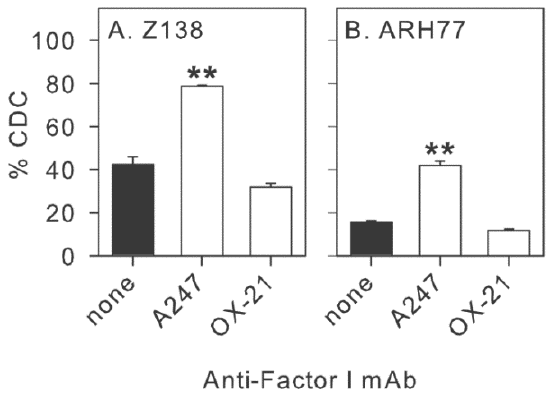
Figure 4. ( A , B ) Not all mAbs specific for Factor I increase CDC. Z138 cells ( A ) or ARH77 cells ( B ) were opsonized with 10 µg/mL rituximab (RTX), washed and then incubated in the presence or absence of 45 ug/mL mAb A247 or mAb OX-21 and 45% NHS for 15 min at 37